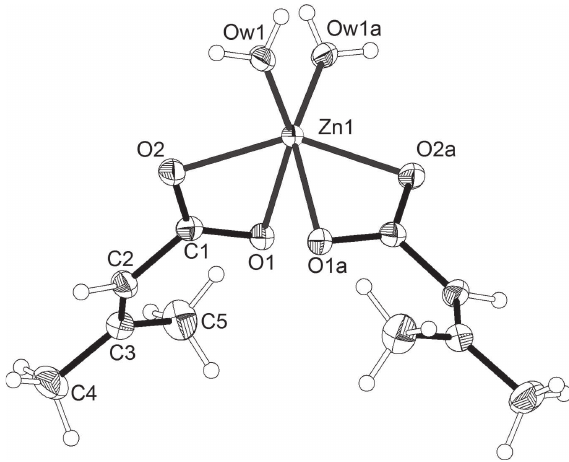
Table 2: Fractional atomic coordinates and isotropic or equivalent isotropic displacement parameters (Å 2